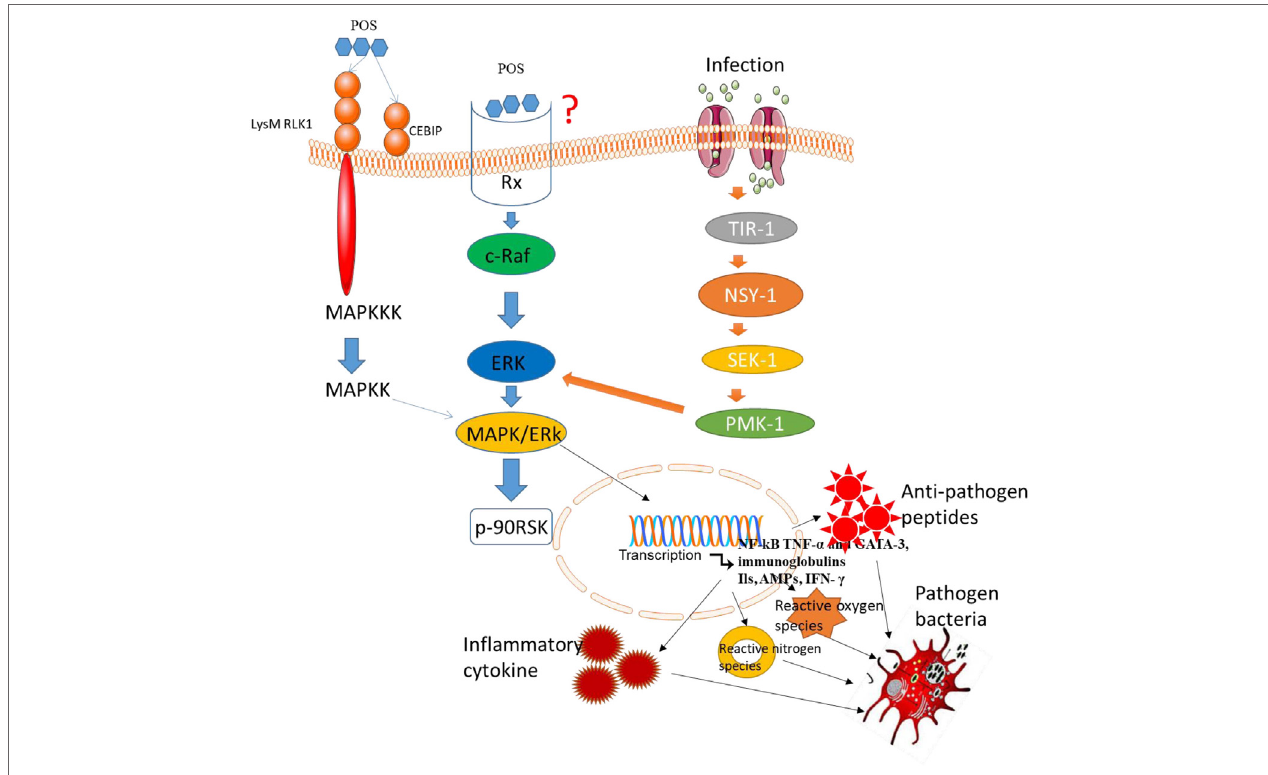
FiguRe 4 | Pectin oligosaccharides binds potential membrane receptors in mitogen-activated protein kinases/ERK signaling pathway. LysM RLK1, chitin elicitor-binding protein, and RX are potential receptors in the